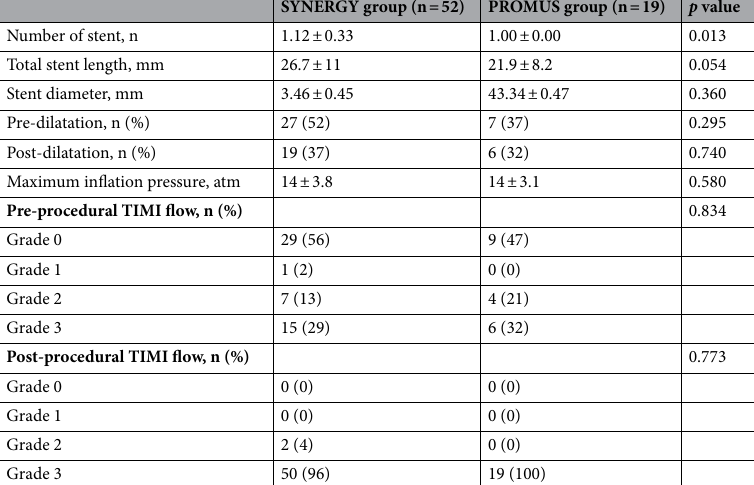
Table 2. Procedural characteristics. TIMI: Thrombolysis in Myocardial